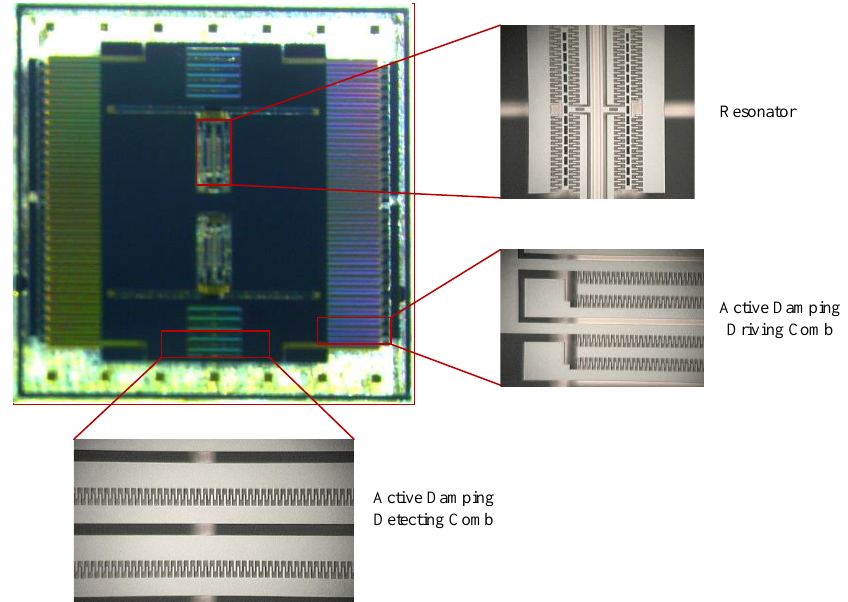
Figure 11. Photographs of the fabricated accelerometer structure.